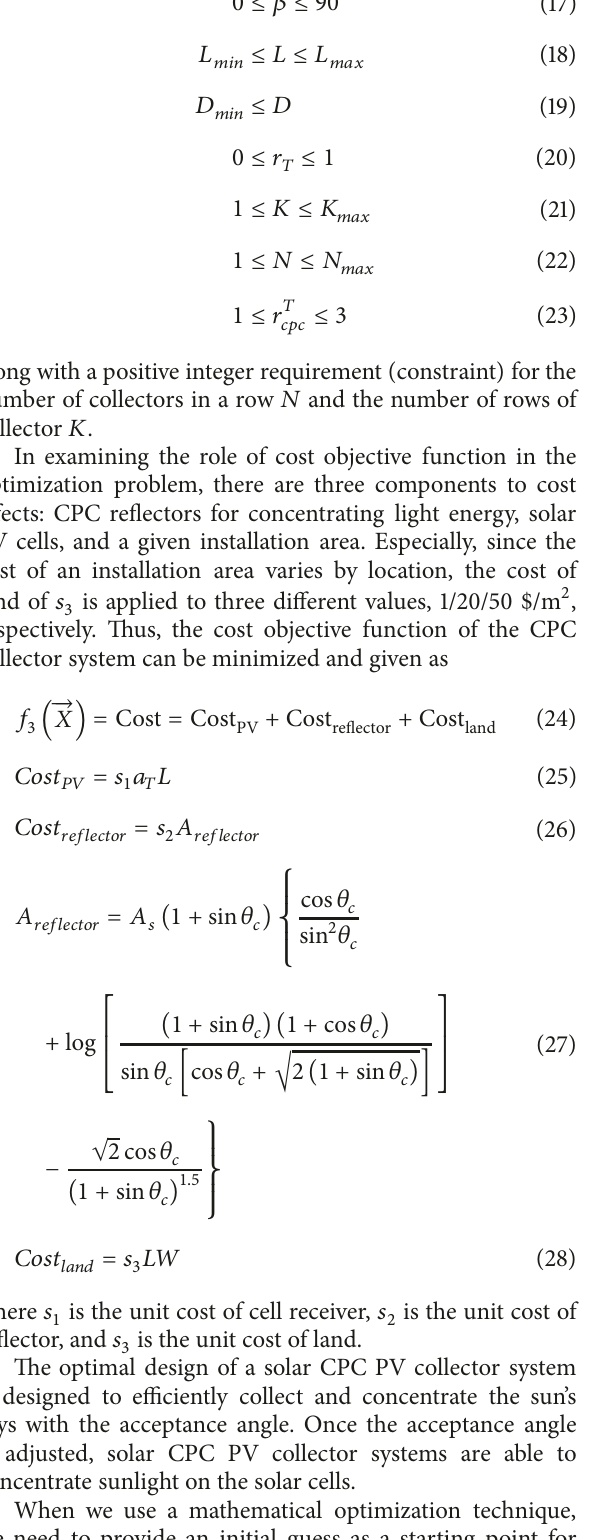
algorithm. The results of the single-objective